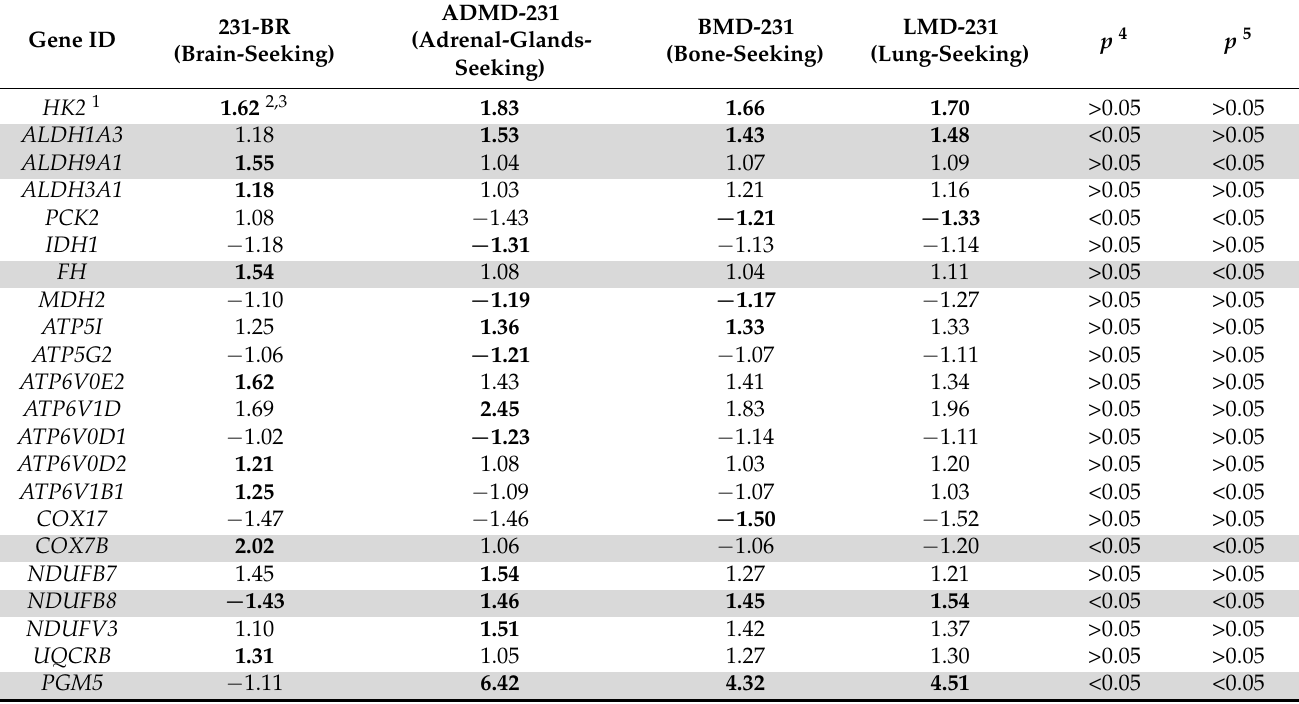
Table 1. Metabolic genes differentially expressed in 231-BR versus other tissue-specific variants of parental MDA-MB-231 human breast cancer